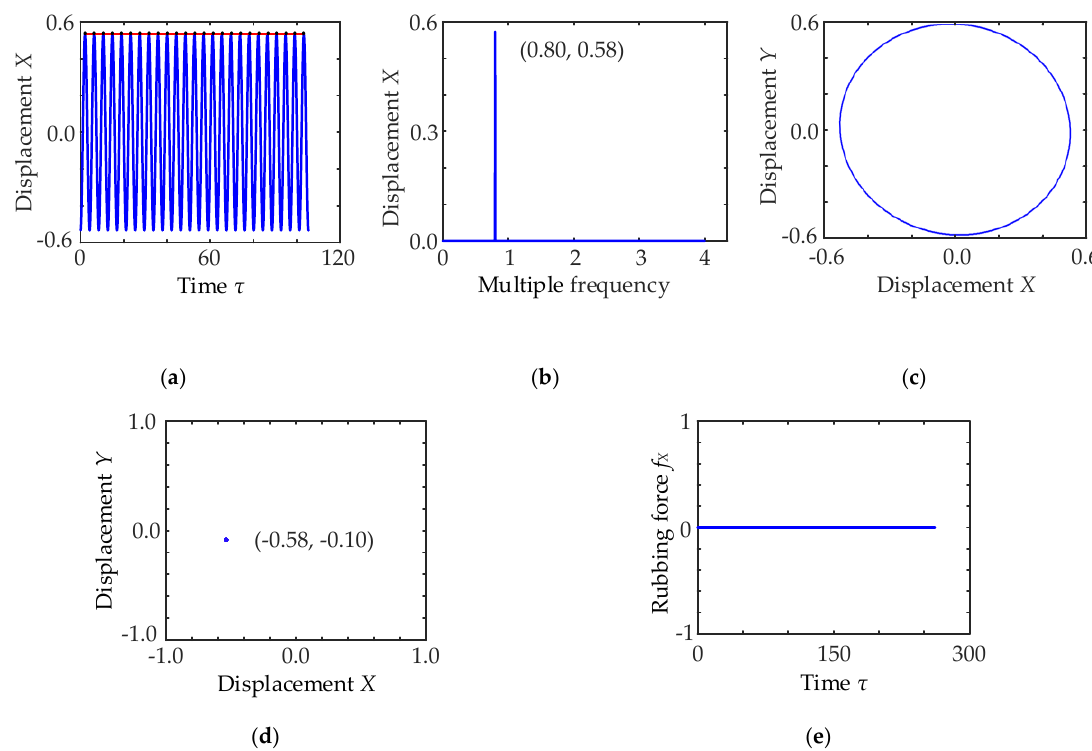
Figure 13. Rotor displacement when n = 13.5 krpm. ( a ) x - t ; ( b ) Amplitude spectrum; ( c ) Rotor trajectory; ( d ) Poincare mapping; ( e ) Rubbing force.